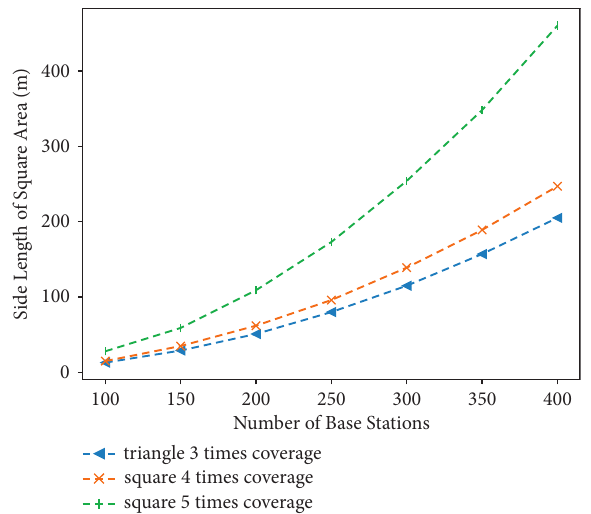
Figure 2: Number of BSs required for different coverages in the same